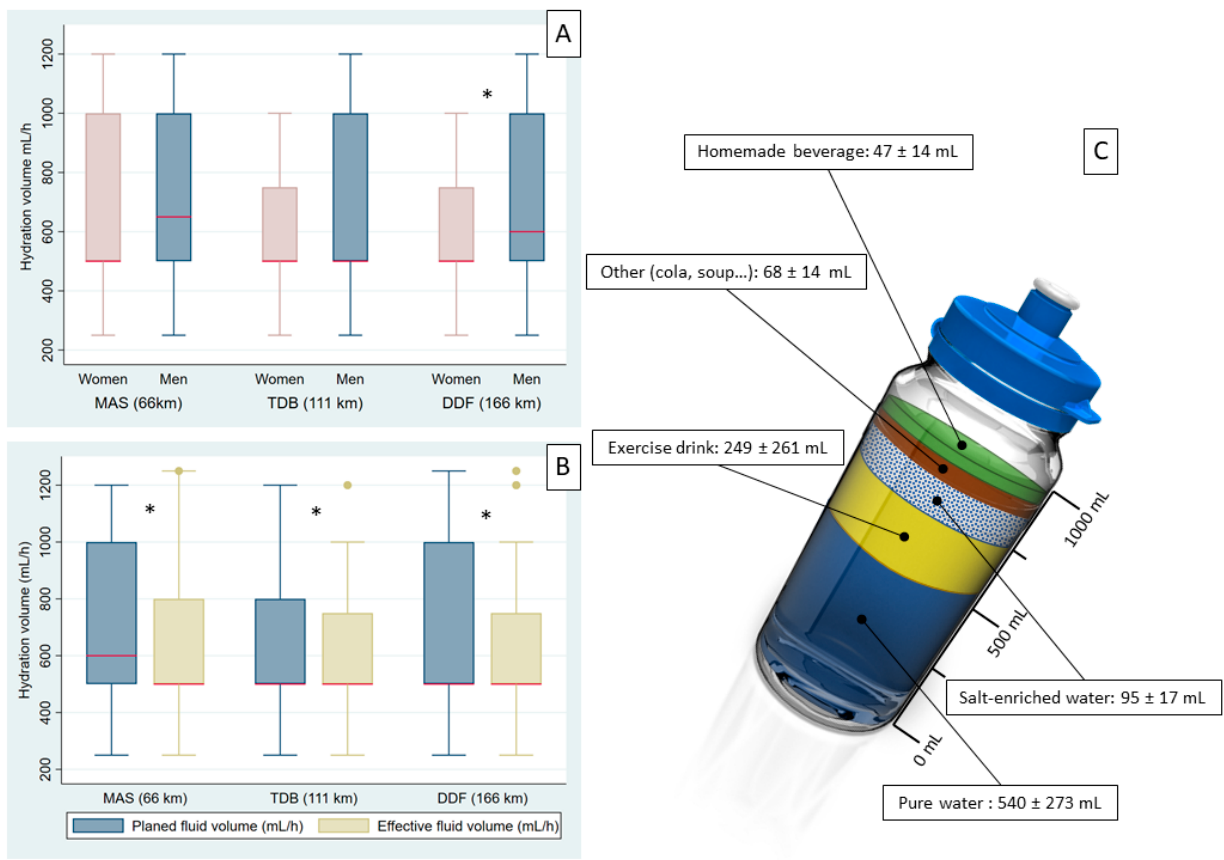
Figure 2. Hydration strategies of runners of the “Grand Raid de la Réunion” 2019 edition. MAS: La Mascareignes , TDB: Le Trail de Bourbon , DDF: La Diagonale des Fous . ( A ) Hydration volume in mL/h according to race and sex. * Significant difference between men and women. ( B ) Planned and effective hydration volume in mL/h reported by runners according to race. * Significant difference between planned and effective hydration volume. ( C ) Distribution of beverage types extrapolated on a 1-L bottle. Data are presented in milliliters (mL) with mean ± SD.